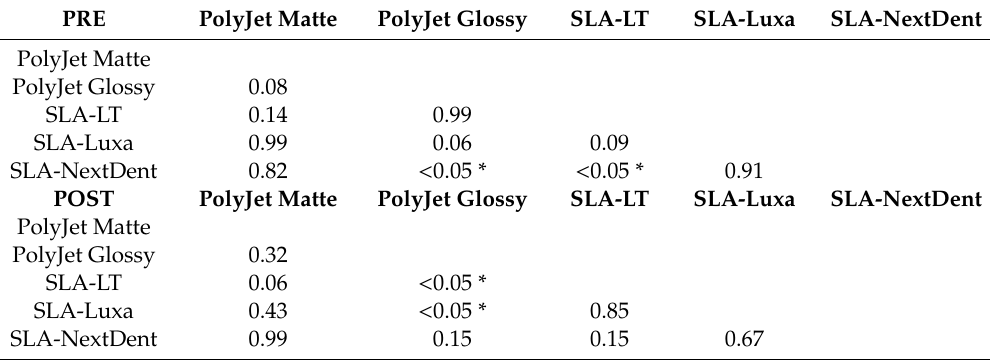
Table 3. Statistical comparison of overall pre- and post-sterilization